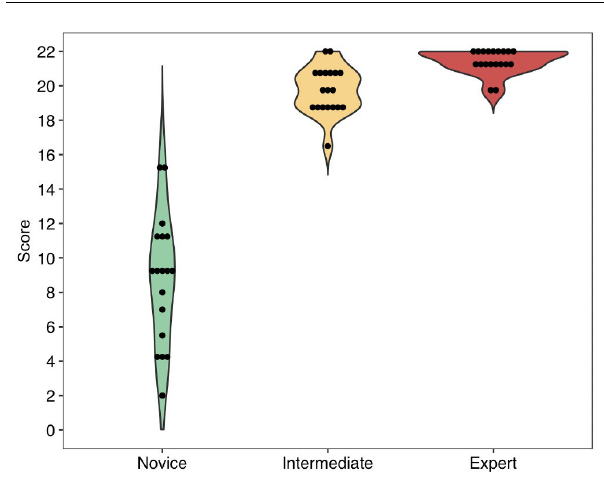
Figure 5. Distribution of Overall Test Scores by Expertise